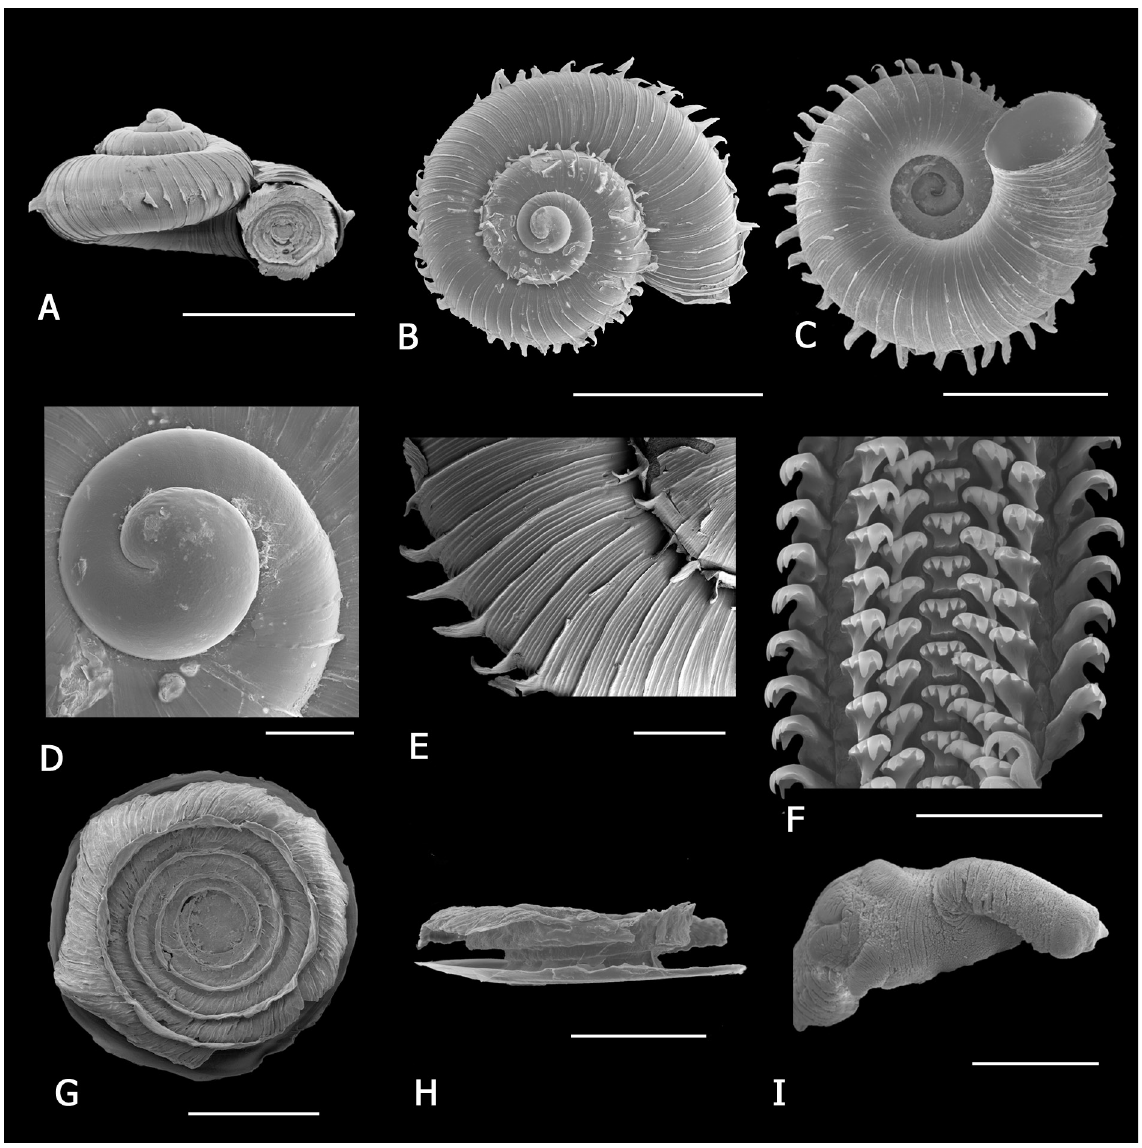
Fig. 12. Chondrocyclus herberti sp. nov. A . Aperture view (NMSA V8576/T4129). B . Dorsal view (ELM W3691/T42). C . Ventral view (ELM W3691/T42). D . Protoconch (NMSA V8632/T4127). E . Detail of axial lamellae of periostracum (NMSA V8576/T4129). F . Portion of radula (ELM W3691/T42). G–H . Operculum (ELM W3691/T42). I . Penis, dorsal view, showing position behind right tentacle (ELM W3691/T42). Scale bars: A–C = 2 mm; D = 200 µm; E, G–H = 500 µm; F = 50 µm; I = 1